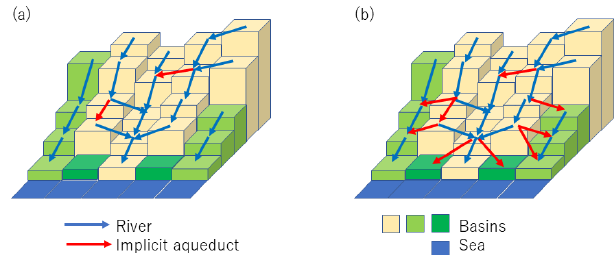
Figure 3. Implicit aqueducts. (a) The original scheme, which does not allow interbasin transfer. Many coastal grid cells (shown in dark green) are prone to water scarcity because they have a limited catch- ment area. (b) The new scheme which conditionally allows inter- basin transfer. Coastal grid cells receive interbasin water transfer from neighboring basins. Columns represent land grid cells. The height indicates each grid cell’s mean elevation. Colors indicate dif- ferent